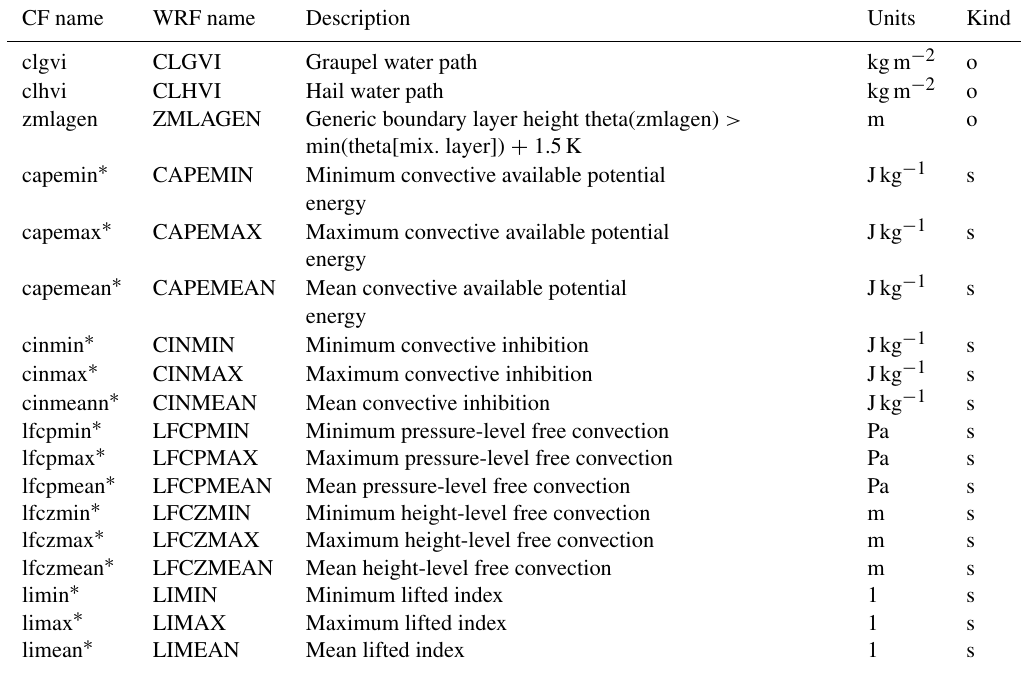
Table B2. As in Table B1, but for the description of CORDEX Tier 1 variables provided with the